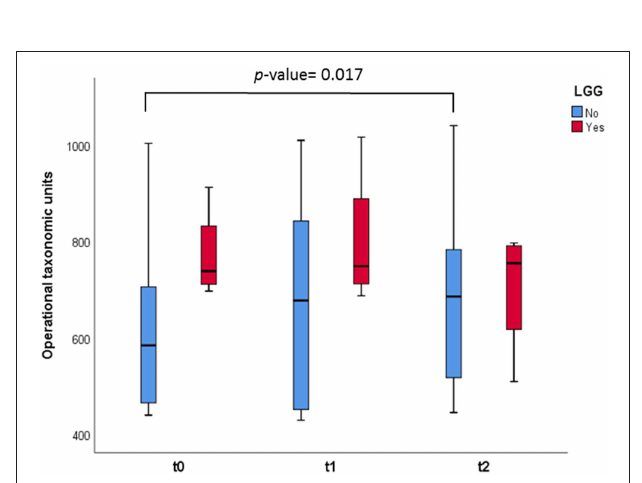
FIGURE 2 | Box and whisker plots representing measurement of OTUs observed in the fecal samples. The infants were divided in two groups: those who consumed the probiotic LGG ( n = 4, in red), and those who did not ( n = 8, in green). Comparisons were made with the Wilcoxon signed-rank test to examine the differences over time ( t = 0, t = 1, and t = 2).